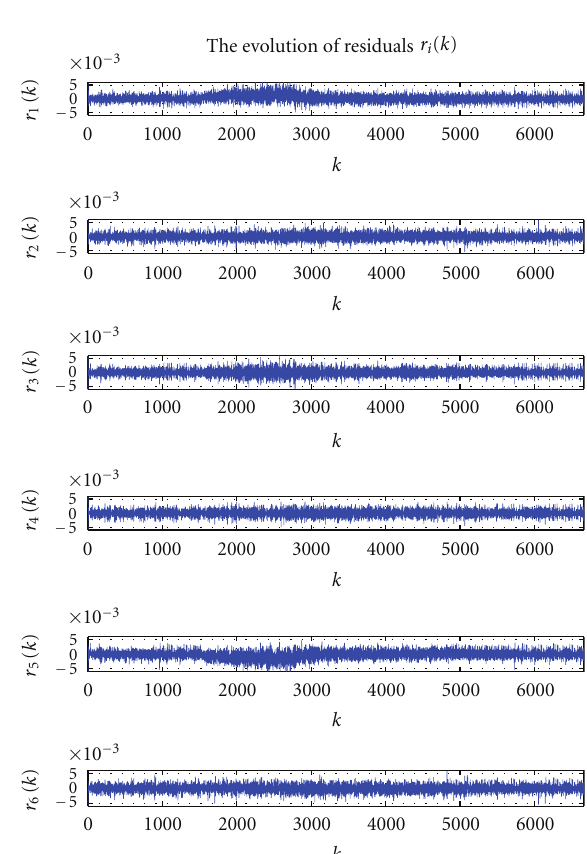
Figure 4: Residuals r i ( k